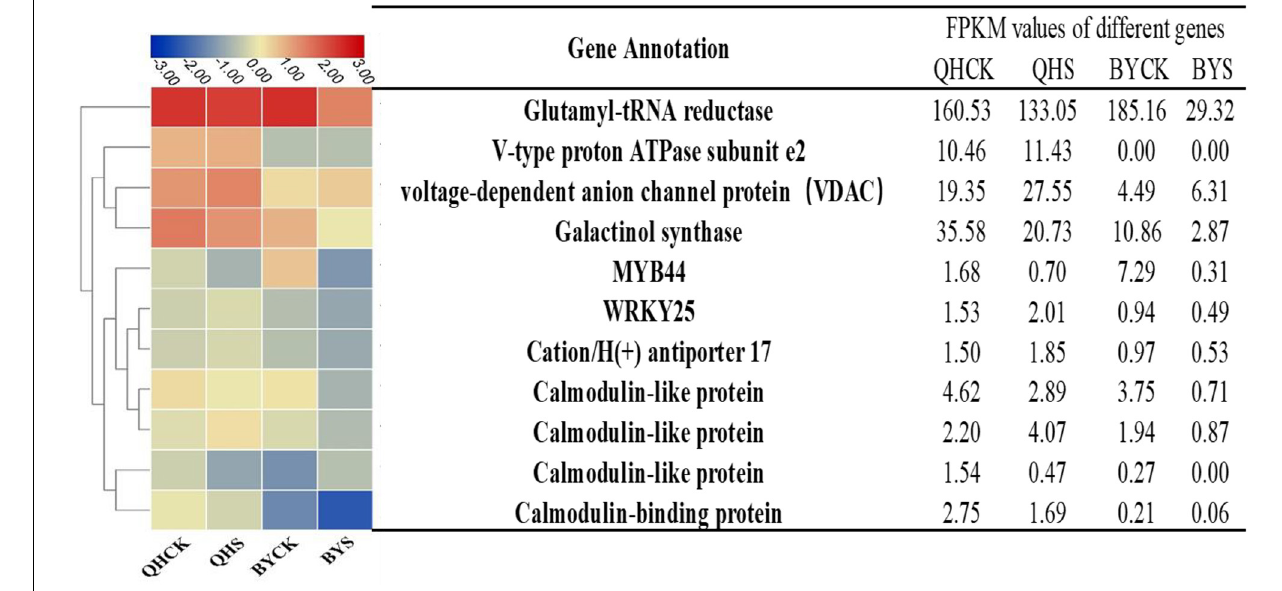
FIGURE 8 | Heat map analysis of FPKM values of 11 key DEGs responding to salt stress in the transcriptome data in Qinghua45 (QH) and Biyuchunhua (BY). Color scale represents FPKM values. Data are the means of three